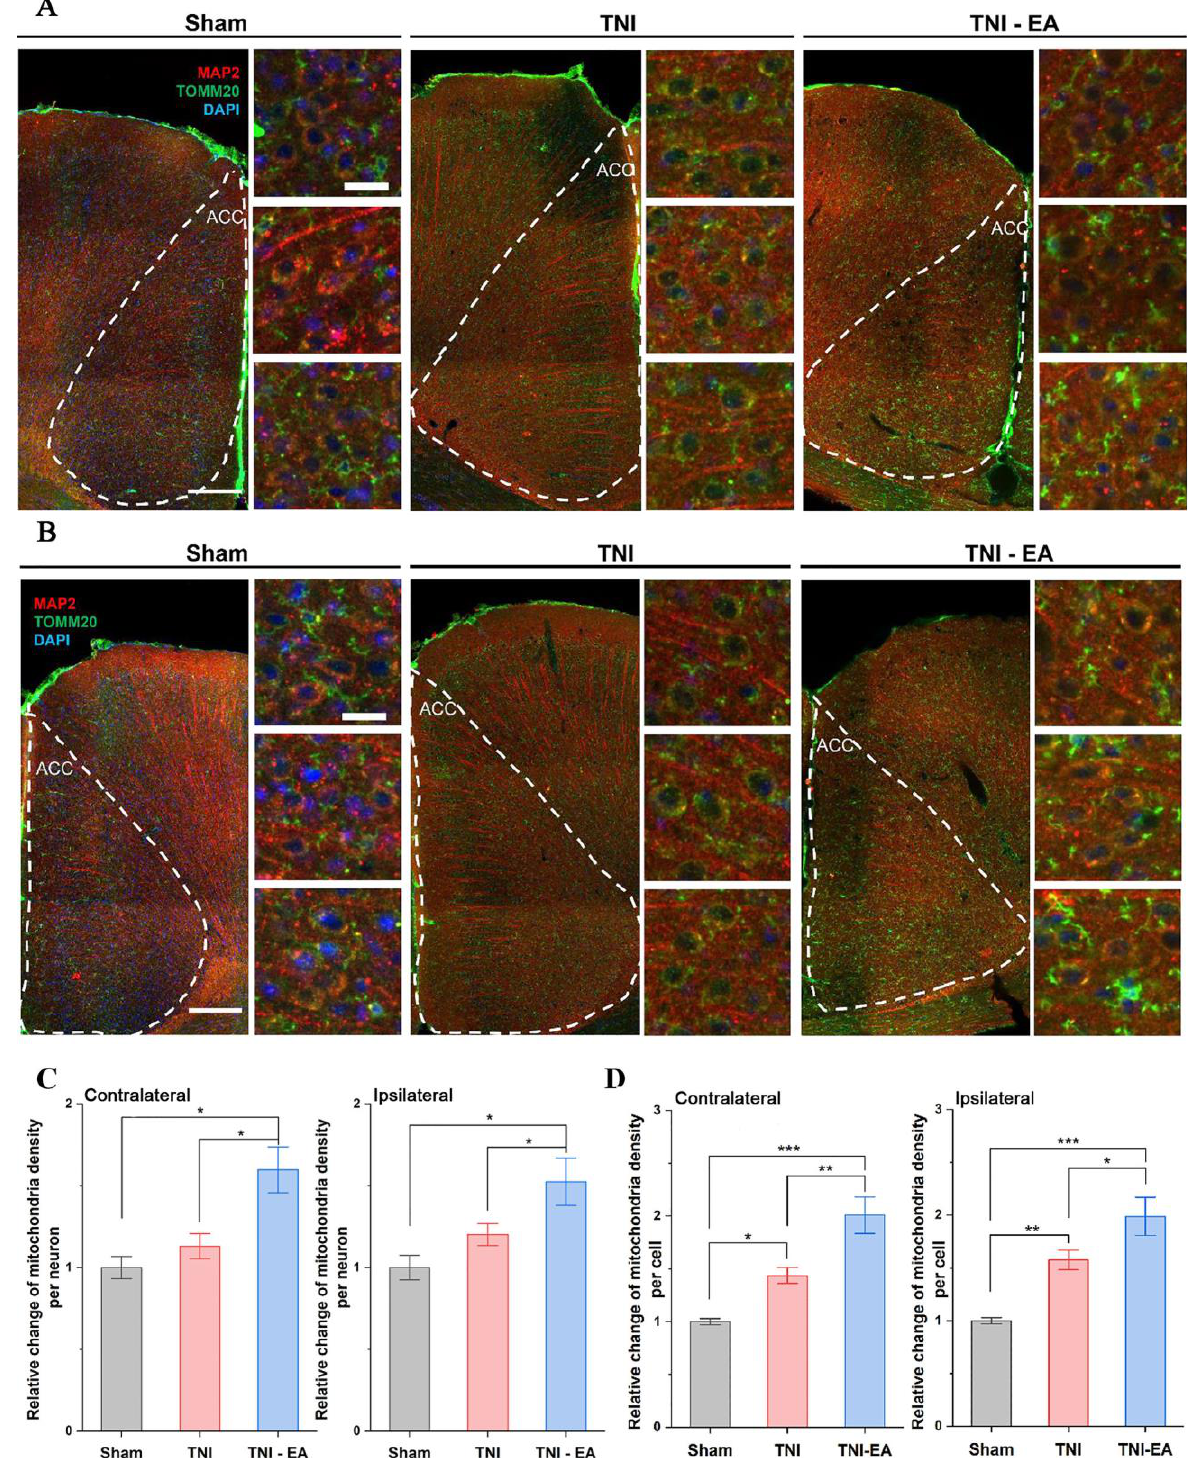
Figure 6. Contralateral ( A ) and ipsilateral ( B ) sides of ACC stained for mitochondria marker Tomm20 and MAP2 using samples from sham ( left ), TNI ( middle ), and EA-treated TNI ( right ) mice. Scale bar = 200 µ m (for 300 × zoom-in view, scale bar = 20 µ m). Mitochondrial density was calculated based on the Tomm20 density per neuron ( C ) and per cell ( D ). N = 4. *, **, ***: p < 0.05, 0.01, 0.001, one-way ANOVA followed by Fisher’s LSD post hoc test.